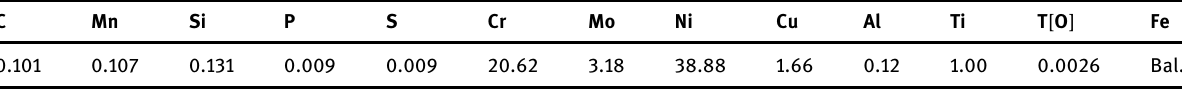
Table 2: Chemical composition of the Incoloy 825 alloy ( % )